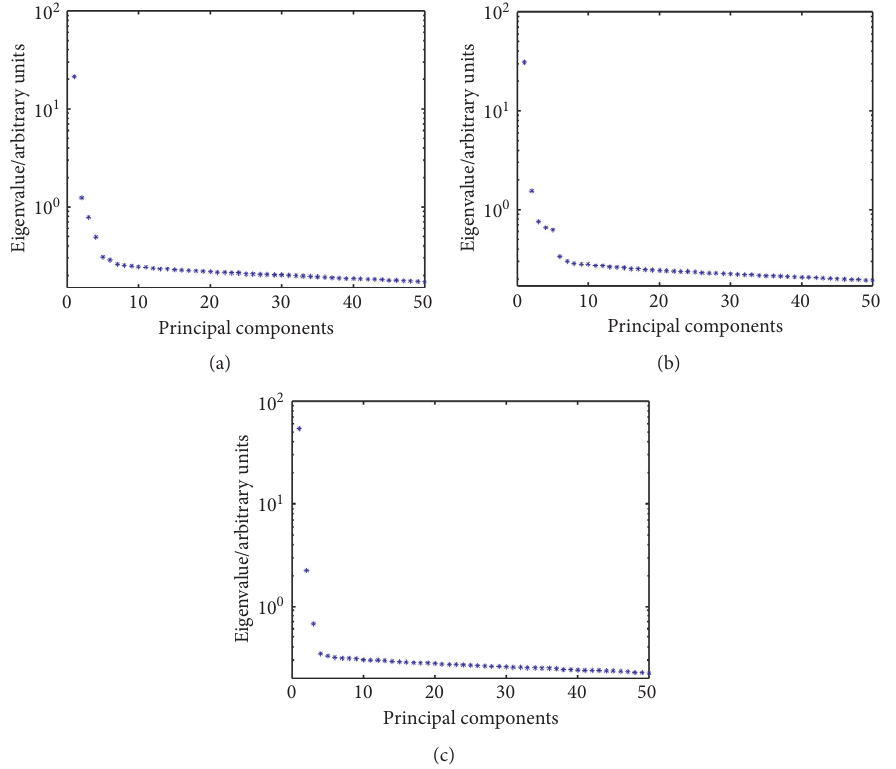
Figure 4: Scree plots showing eigenvalues explained as a function of the number of principal components for (a) stage 1, (b) stage 2, and (c) stage 3 datasets. For the sake of clarity, only the first 50 principal components are shown.